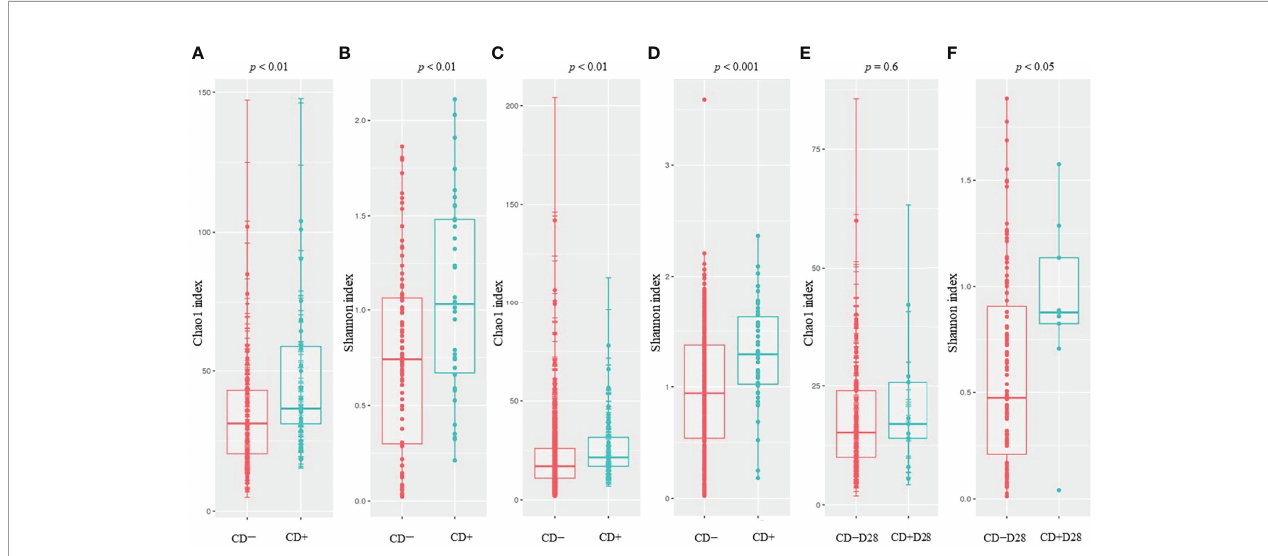
FIGURE 1 | Comparison of the Chao1 and Shannon indices for ClosNEC [ (A) and (B) ], EPIFLORE_D28 [ (C) and (D) ] and EPIFLORE_D7_2 [ (E) and (F) ], respectively. Red, CD − (ClosNEC, EPIFLORE_D28) or CD − D28 (EPIFLORE_D7_2); blue, CD+ (ClosNEC, EPIFLORE_D28) or CD+D28 (EPIFLORE_D7_2). Boxplots represent the median and the 1 st and 3 rd